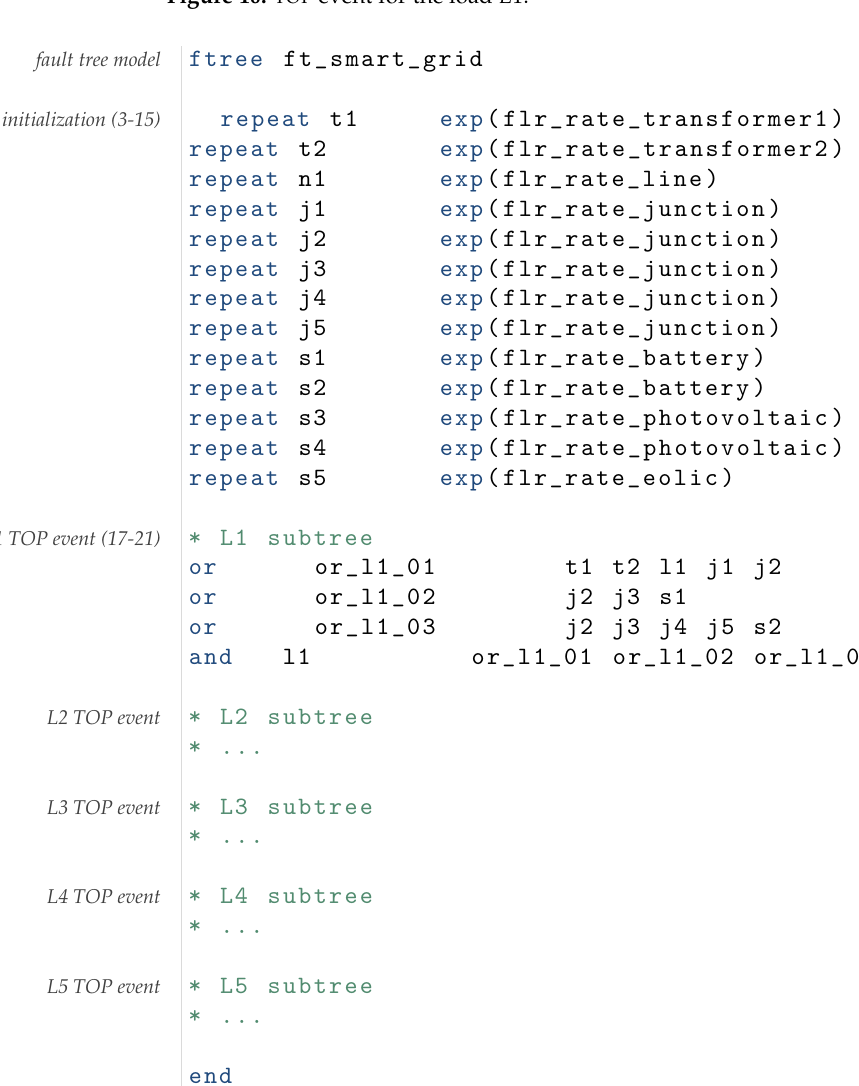
Figure 10. TOP event for the load L 1.